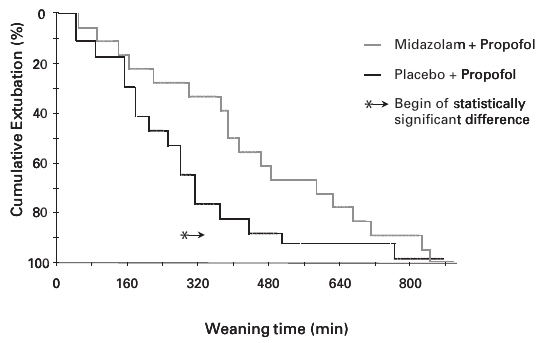
* Begin of statistically significant difference